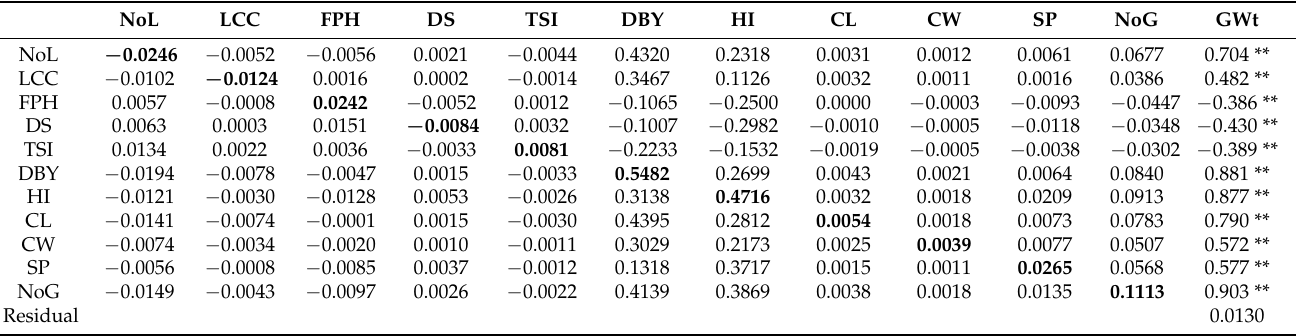
Table 3. Direct (bold diagonal) and indirect effects of selected maize growth and yield traits on grain weight under no stress (NHWS) conditions.